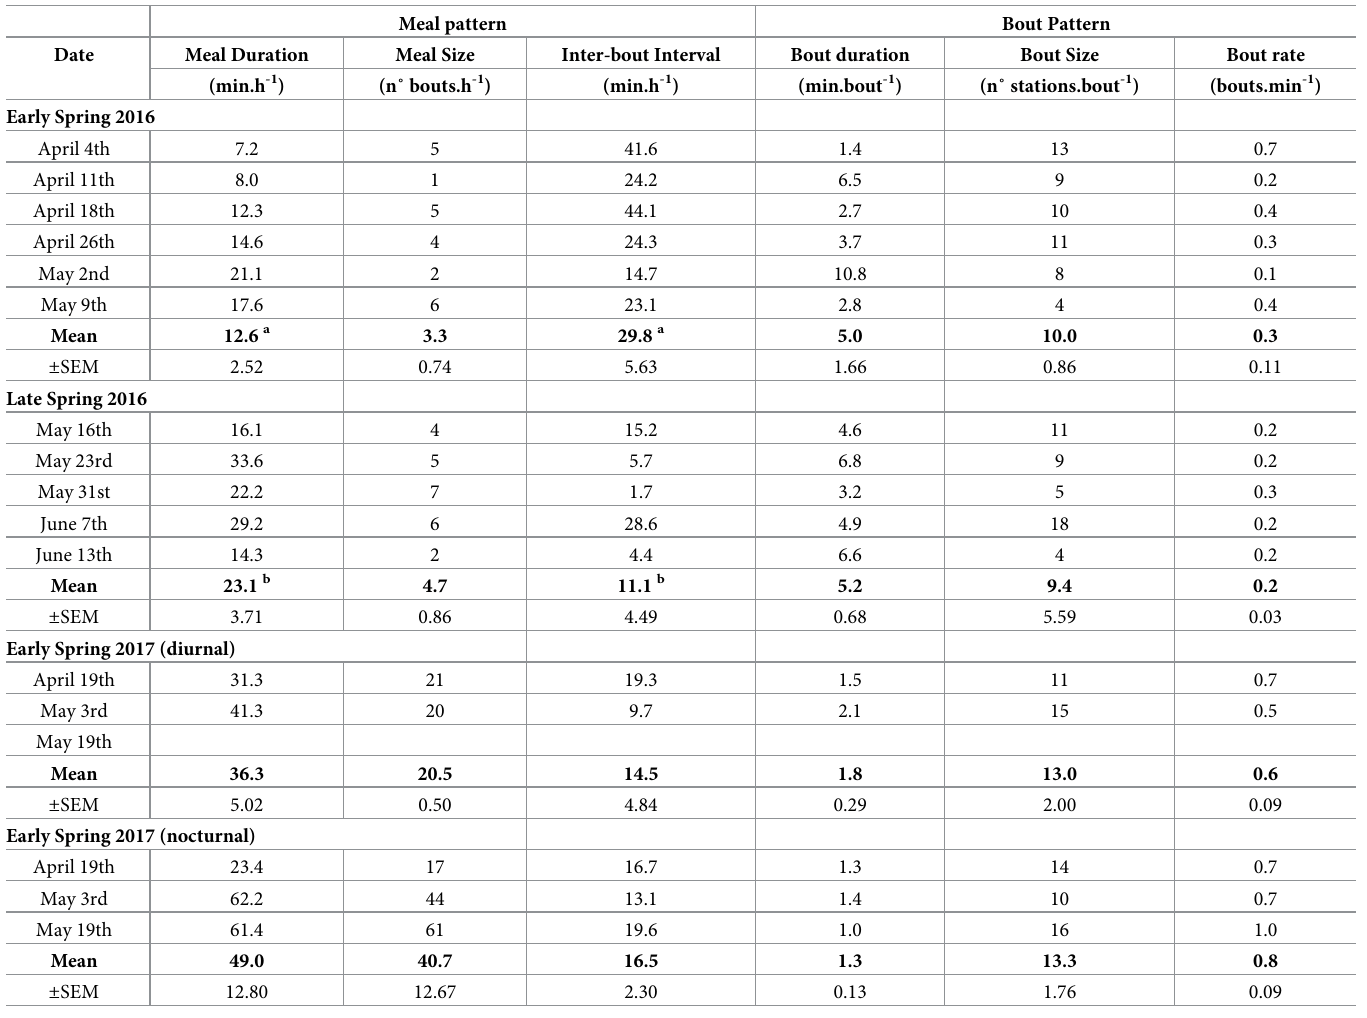
Table 2. Weekly variation in structure of intake (meal and bout patterns).